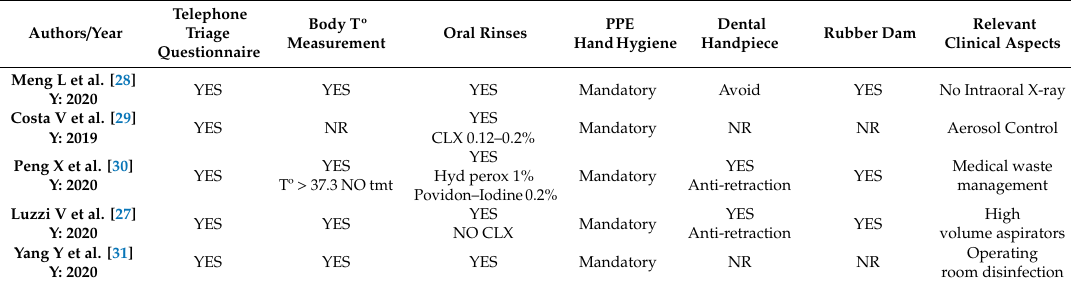
Table 1. SARS-CoV-2 guidelines in